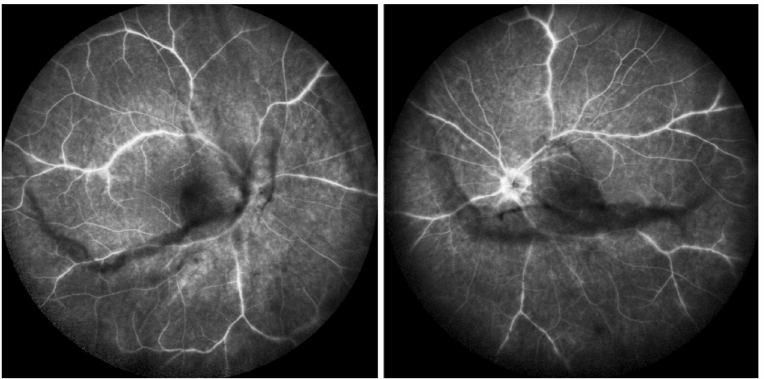
Figure 39. Retinal and vitreous involvement in BRC. Large strands of vitreous opacities and widespread retinal vasculitis.